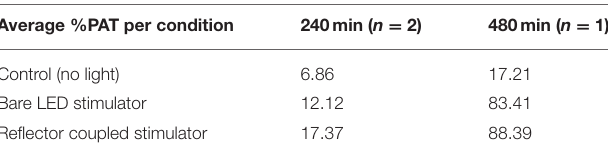
TABLE 1 | Average %PAT (multiplied by a factor of 10,000 to facilitate comparison) for control, bare LED stimulator and reflector coupled stimulator. Average %PAT per